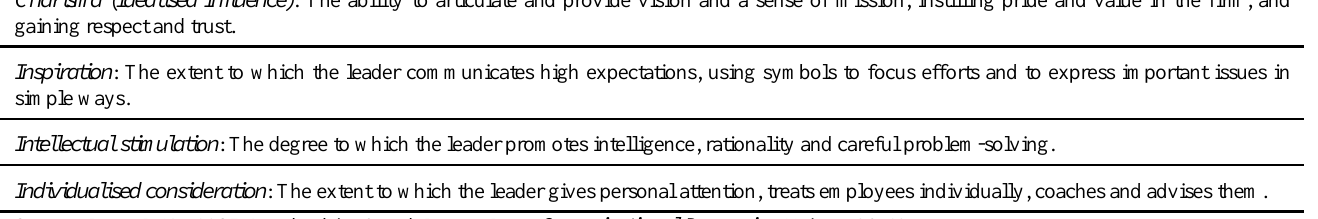
Table 2: Constructs of transformational leadership Charisma (Idealised Influence) : The ability to articulate and provide vision and a sense of mission, instilling pride and value in the firm, and gaining respect and